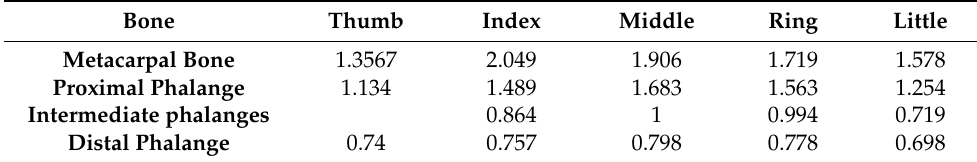
Table 2. Anatomic human hand